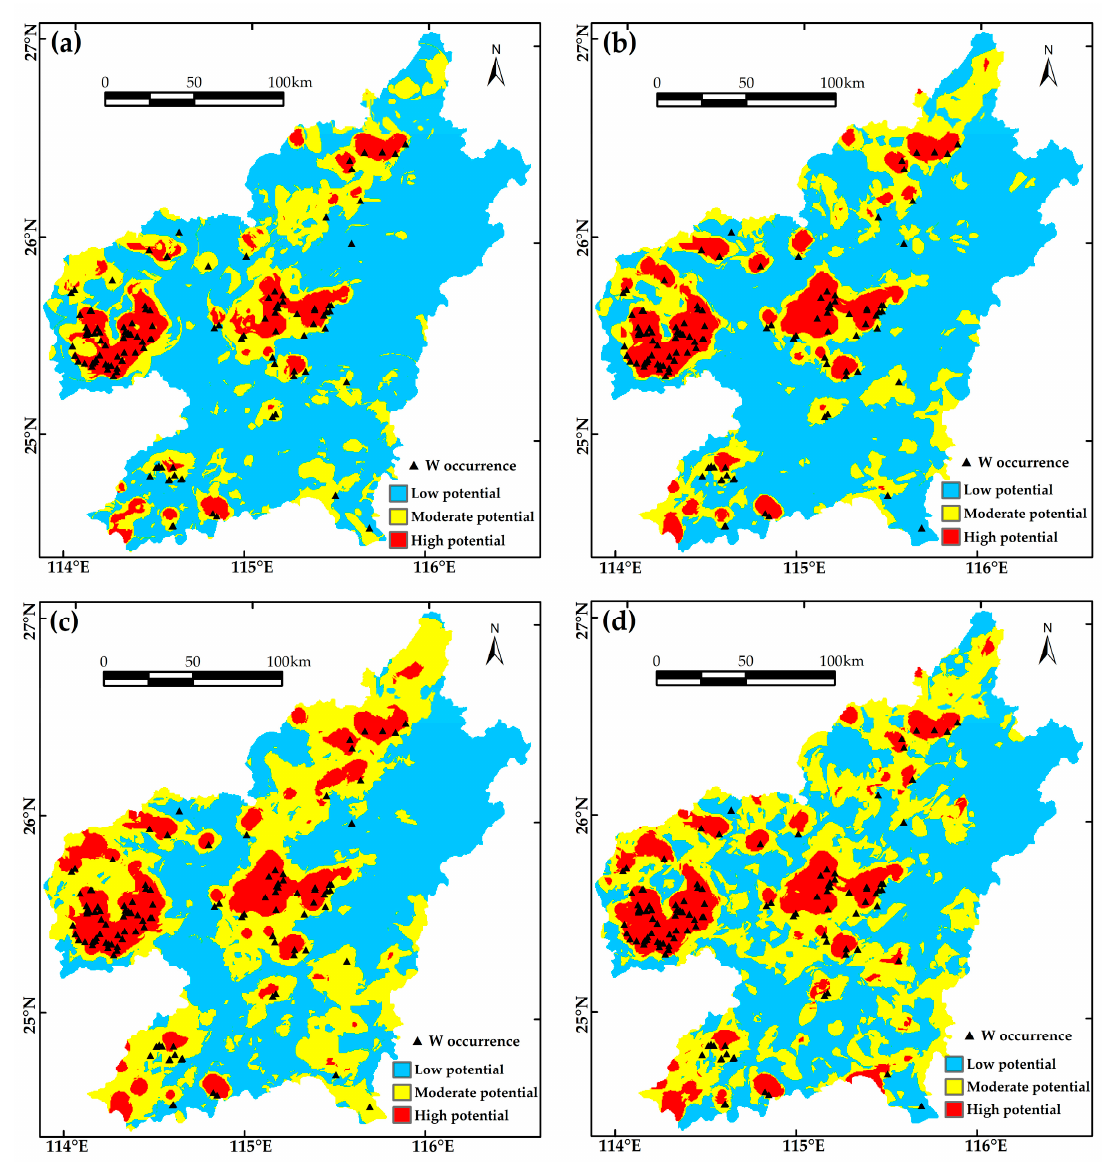
Figure 13. Prospectivity maps of ( a ) RF, ( b ) SVM, ( c ) ANN, and ( d ) CNN models showing different potential areas delineated by the thresholds identified from Figure 12.